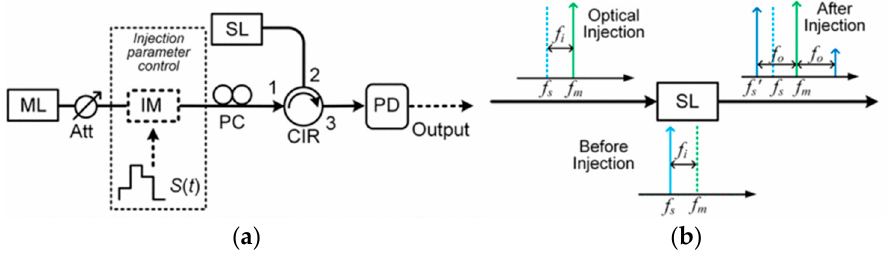
Figure 5. ( a ) Schematic diagram of the period-one (P1) nonlinear dynamic-based frequency-hopping signal-generation scheme. ( b ) Operation principle of P1 dynamics in an optically injected semiconductor laser. ML: master laser, Att: optical attenuator; IM: intensity modulator, S(t): hopping code sequence; PC: polarization controller, CIR: optical circulator; SL: slave laser, PD: photodetector (with the courtesy of Dr S. Pan).